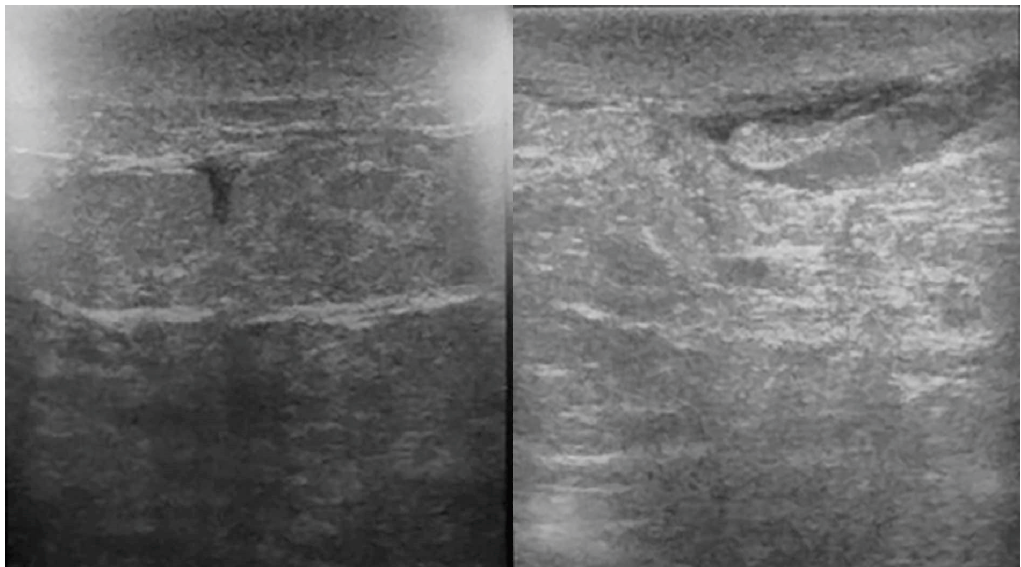
Figure 2. Ultrasound of both breasts without conclusive findings.